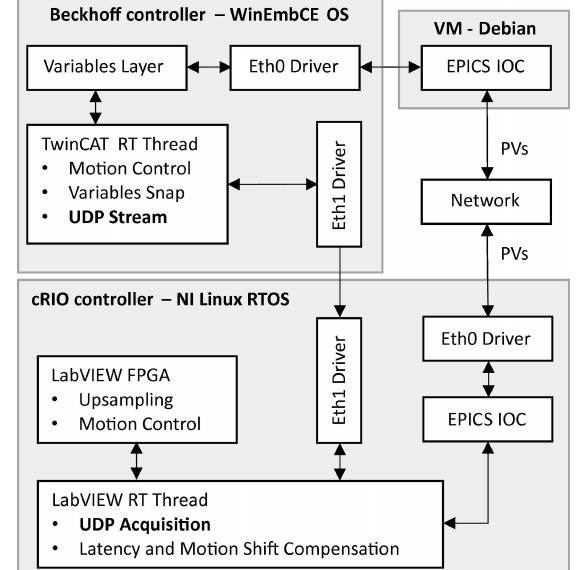
Figure 7 Upgraded integration topology between the APU22 and the HD-DCM at EMA and MANACA´ . The APU22 uses a Beckhoff controller with a Windows Embedded CE operating systems (OS) and an external virtual machine (VM) with a Debian OS for the EPICS IOC server. The HD- DCM is based on an NI linux real-time operating system (RTOS), with an embedded EPICS IOC server for EPICS process variables (PVs). A direct Ethernet (Eth) link using UDP (user datagram protocol) for setpoint streaming is now available for follower mode operation. Further details can be found in the